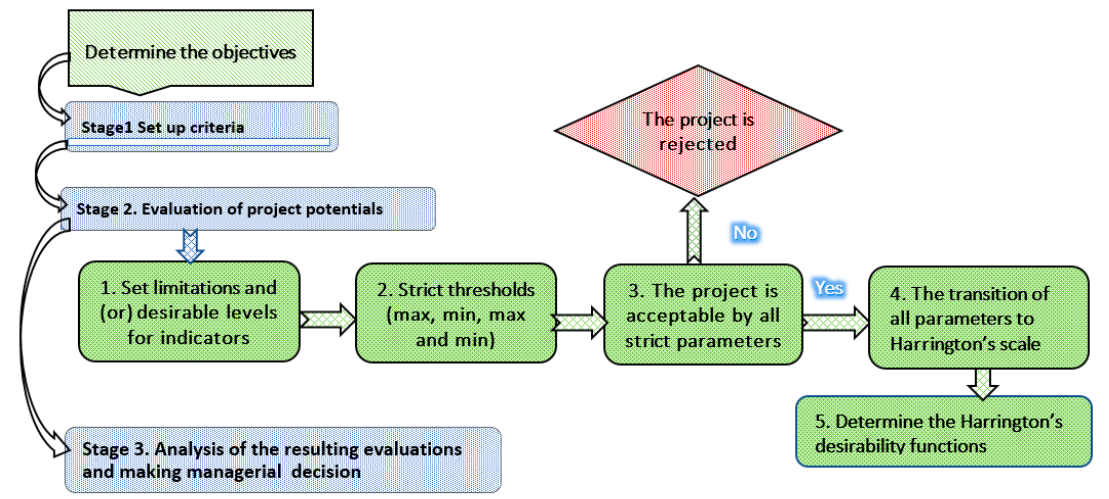
Figure 3. A flowchart for the methodology of evaluating industrial ecosystem projects. Source: own